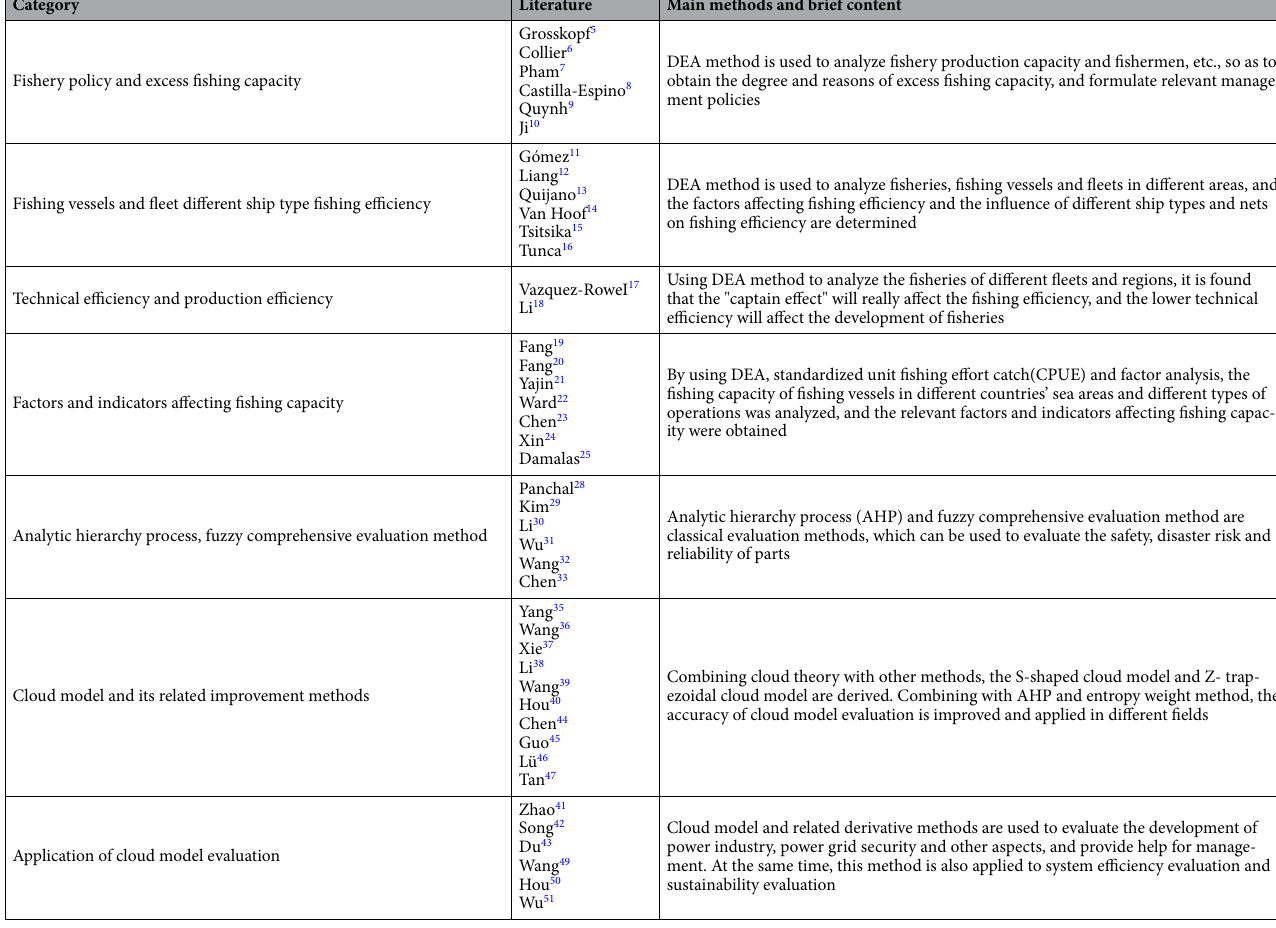
Table 1. literature